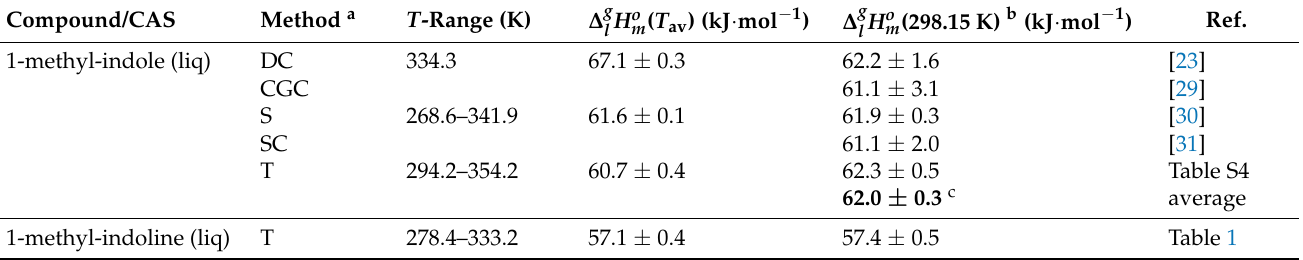
Table 4. Compilation of available enthalpies of vaporization, ∆ g methyl-indoline.